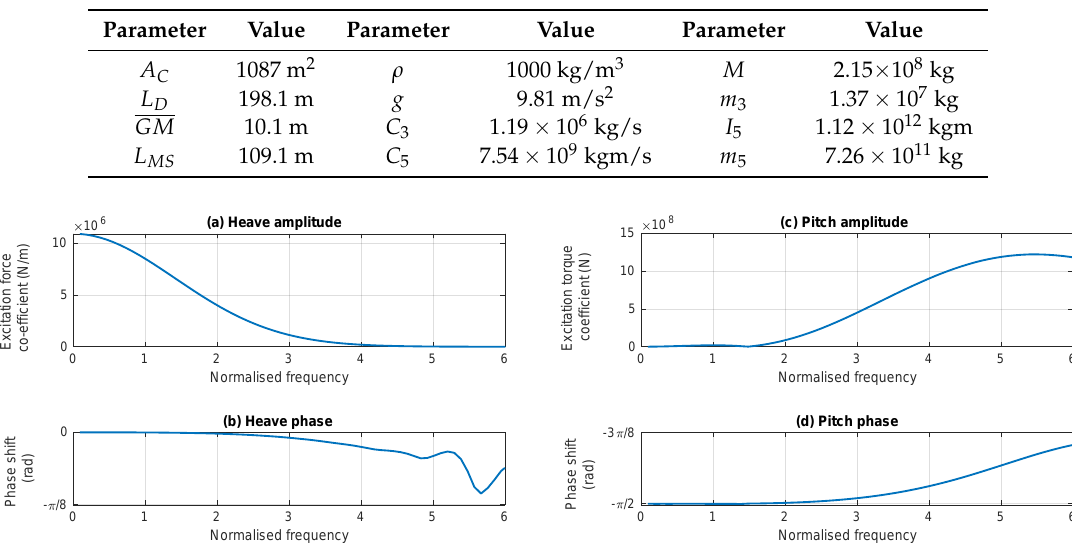
Figure 2. The excitation force coefficients ( a ) H E ,3 , ( b ) φ E ,3 , ( c ) H E ,5 and ( d ) φ E ,5